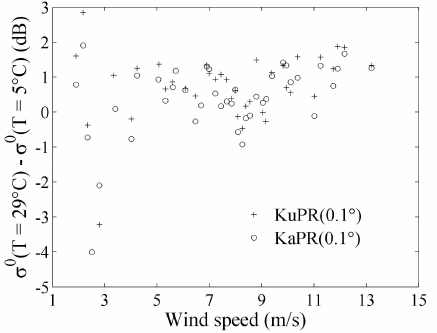
Figure 18. Magnitude of the difference of σ 0 between different sea surface temperatures ( T = 29 ◦ C and T = 5 ◦ C) at 0.1 ◦ incidence angle with respect to wind speed. Plus signs are for KuPR and circles are for